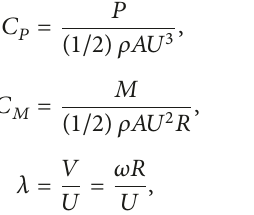
Figure 3: Computational region diagram and boundary conditions. Table 2: Component of the experimental